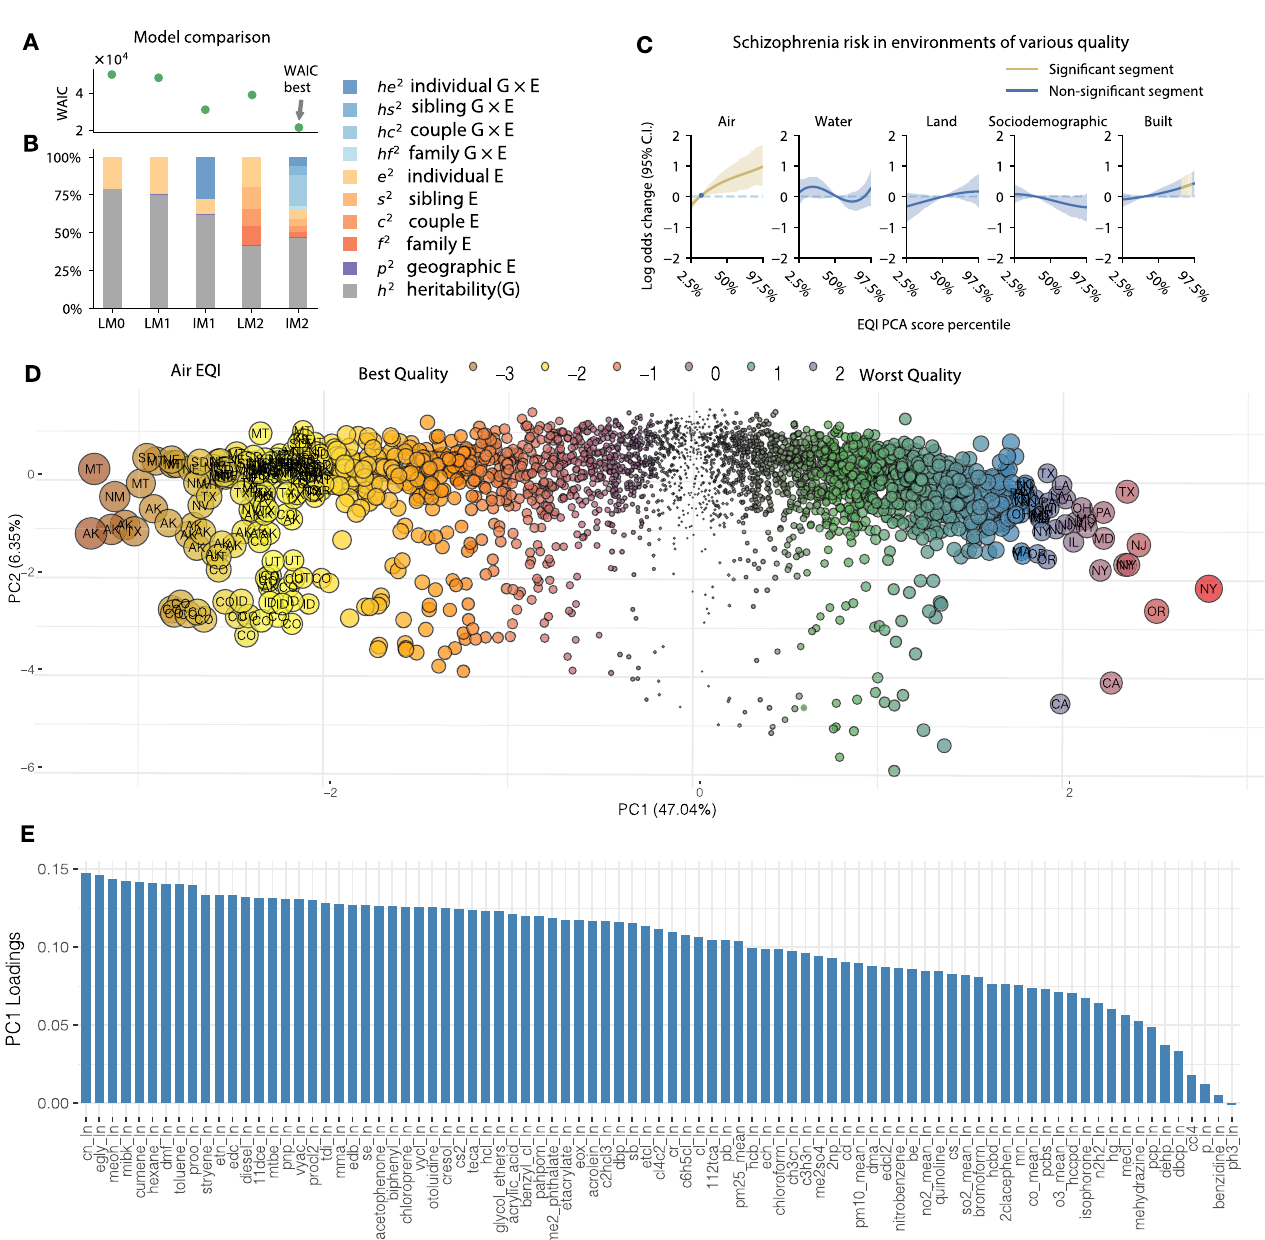
Fig. 1 Comparing fi ve models of phenotypic variation of schizophrenia. Comparing model fi t across a collection of increasingly complex models of schizophrenia heritability: model speci fi c WAIC values ( a ) are juxtaposed with corresponding heritability estimates ( b ), also provided in Supplementary Table 2. a WAIC values quantify goodness-of- fi t of the corresponding models, with a lower WAIC associated with a better model fi t. b Bar plot showing the proportion of outcome variance explained by each effect variable, grouped into four major categories with shaded sub-categories: heritability (gray bars), geographic location (violet bars), environmental factors (yellow-orange bars), and gene – environment interactions (blue bars). c Effect of environmental variables on schizophrenia risk. Plot shows the non-linear effects estimated for the fi ve EQI domains (air, water, land, sociodemographic, and built-environment) based on the WAIC-best model, IM2. To visualize the IM2 results, we converted the EQI scores (PC1 generated by principal component analyses) to percentiles based on the population distributions and used the 2.5th to 97.5th percentiles as the x -axis limits of the plots. Blue and olive segments indicate signi fi cant and non-signi fi cant EQI regions that are associated with the log-odds of schizophrenia, respectively. d Principal component scores of air quality across US counties, each dot in the fi gure correspond to a unique US county where the size of the dot is proportional to their distance from the mean. Selected counties in either extremities are labelled with their state abbreviations. The U.S. EPA computed county-level air quality index using scores of PC1 as proxy for air quality. Red, purple, and blue dots represent counties with poorer air quality (higher PC1 scores). Brown, yellow, or orange dots represent counties with higher air quality (lower PC1 scores). Counties with relatively extreme air quality measures are shown with larger dots. e Loading of the fi rst principal component summarizing a wide range of air pollutants. The full list of air quality indicators is provided in Supplemental Data 1 along with explanation of each measurement